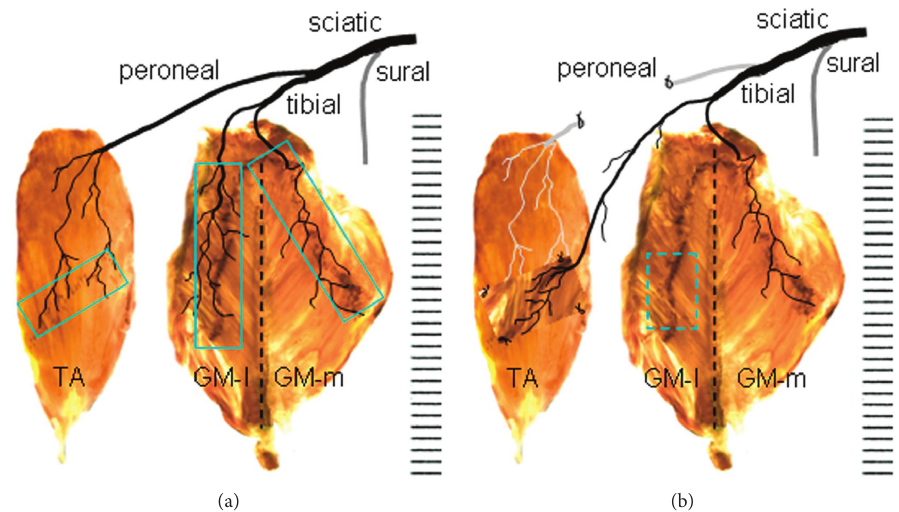
Figure 4: (a) Native motor zones (NMZs) within the TA and GM muscles (boxed regions) as demonstrated by Sihler’s stain and AChE staining. (b) TA denervation and NMEG-NMZ transplantation. The TA is denervated by resecting a segment of the peroneal nerve. The denervated TA is treated with the NMEG-NMZ technique. An NMEG pedicle with a nerve branch is harvested from the NMZ of the GM-l (boxed region) and implanted to the NMZ of the denervated TA